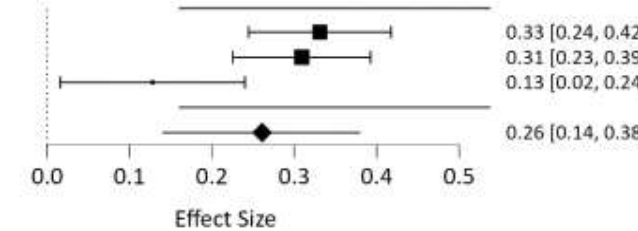
Figure 26. Forest plot of meta-analysis of Motivation for achievement and L2 test success Motivation for stimulation and L2 test success